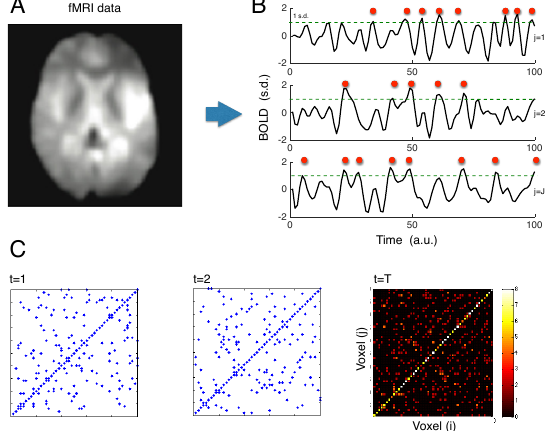
Figure 1: The basic aspects to consider in defining the point process of the BOLD signal. The traces on panel B are examples of raw time series (j) of fMRI BOLD signals at three brain locations (called “voxels”). Time points are selected at the upward threshold crossings or the peaks of the signal (filled circles). The tempo- ral co-occurrence of these points defines co-activation matrices for different lengths of time (graphs in C ), which can be further averaged to estimate the correla- tion matrix for the entire time T of the system under